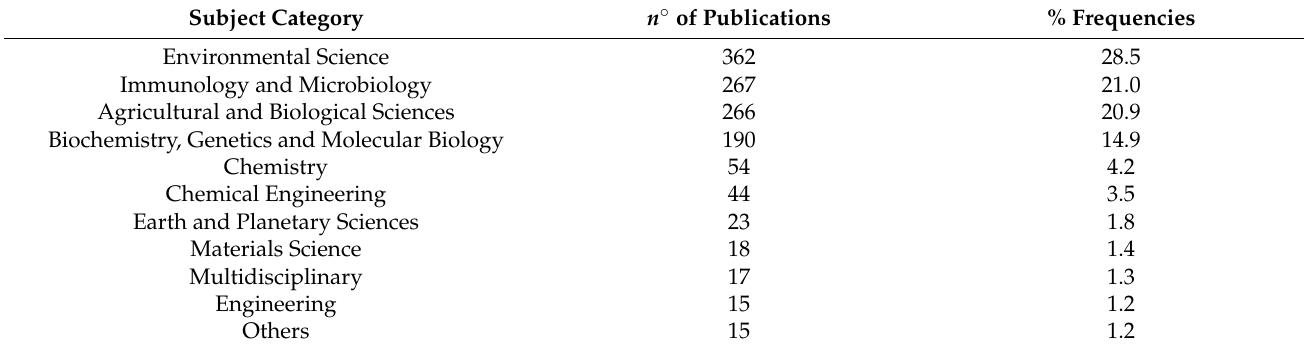
Table 2. The top ten subject categories publishing at least 15